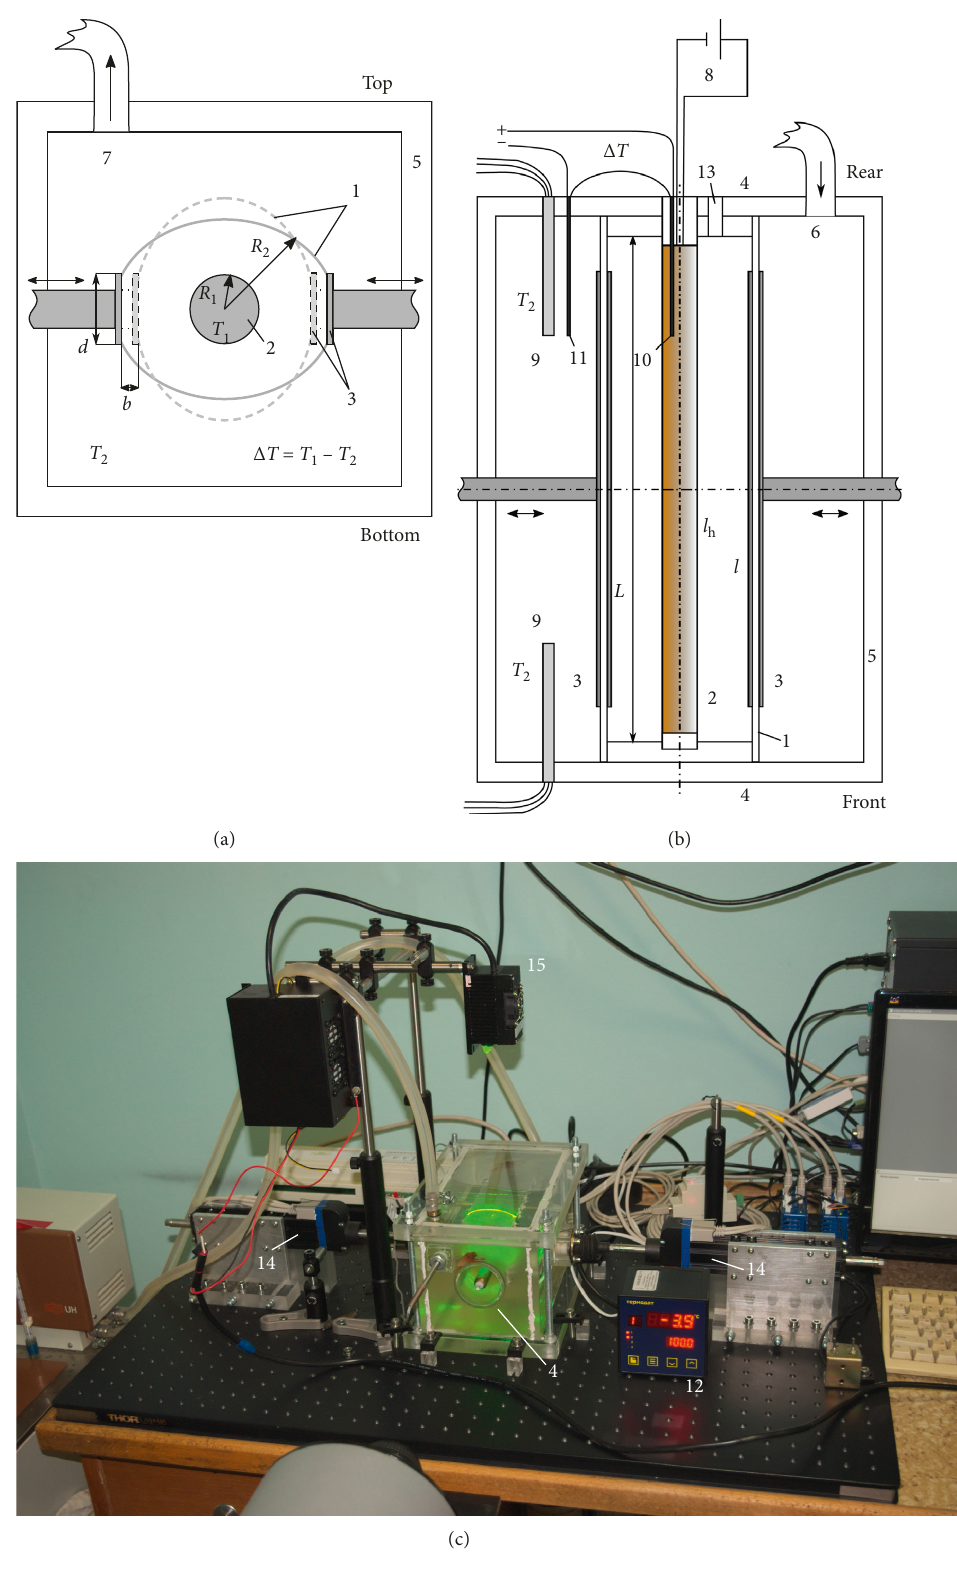
Figure 1: Experimental setup: schematic (not up to scale) of the experimental cell ((a) front view; (b) top view); photograph of the setup ((c) 1—elastic boundary; 2—heat exchanger; 3—activators; 4—transparent flanges; 5—cooling jacket; 6—cooling water inlet; 7—outlet; 8—power supply; 9—thermistors; 10, 11—thermocouple; 12—Termodat; 13—opening; 14—actuators;